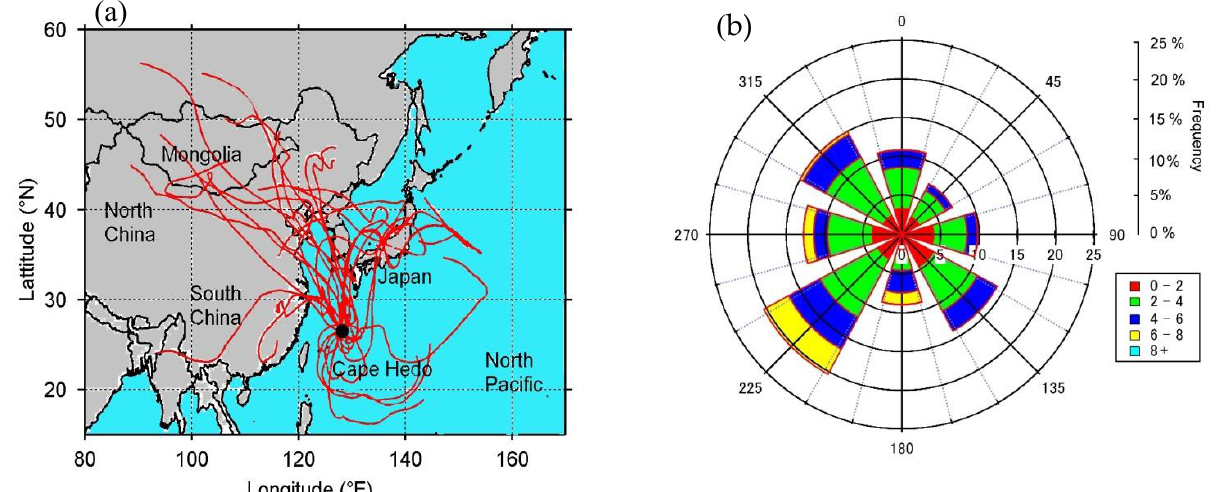
Figure 2. ( a ) Five-day back trajectory analysis using Hybrid Single-Particle Lagrangian Integrated Trajectory (HYSPLIT4) model (Draxler and Hess, 2003). ( b ) Wind direction recorded in Okinawa during study period. Color code labels in rose plot (0 – 2, 2 – 4, etc.) indicate the recorded wind speed in m/s. The meteorological data were obtained from the Japan Meteorological Agency.